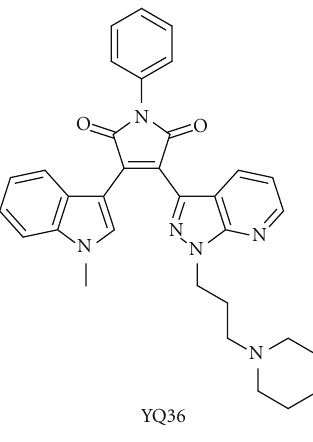
Figure 1: The structure of